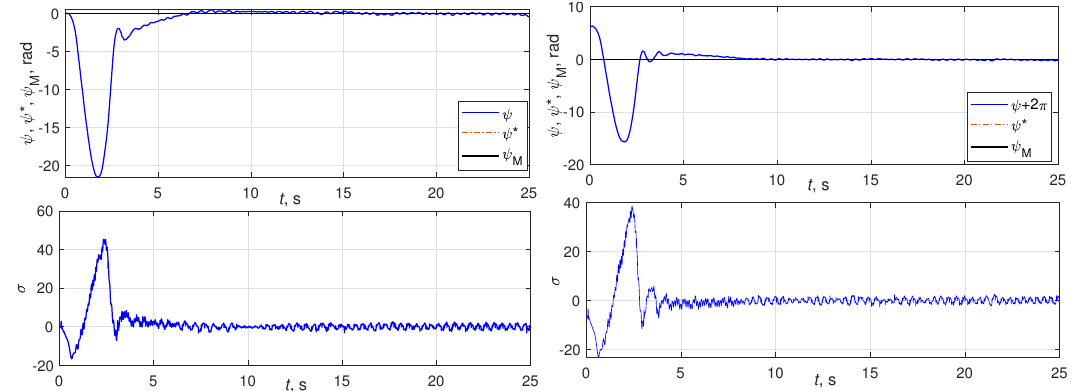
Figure 4. Experiment. ψ ( t ) , ψ ∗ , ψ M ( t ) ( upper plots ) and IMR discrepancy signal σ ( t ) ( lower plots ) time histories for ψ ∗ = 0. Linear error ( left column ), sine-modification ( right column ). As stated above, signal σ , see (26) and (45), can be treated as the discrepancy between the desired and actual system action so that identity σ ≡ 0 corresponds to the reference model (50) output ψ M ( t ) . Equation (50), however, is not a part of the control